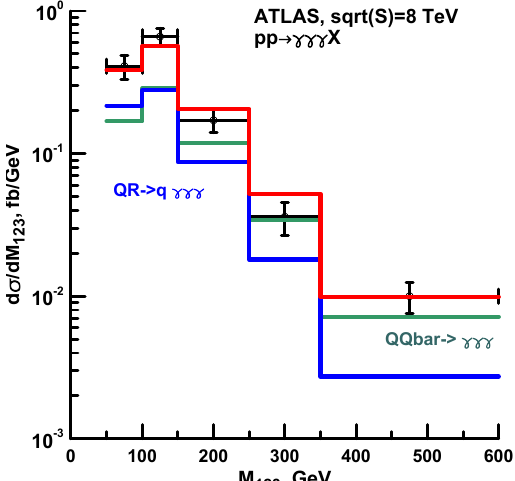
Figure 1: The differential cross sections as function of three-photon invariant mass M . The hard scale in PRA calculation is taken as µ = M 123 corresponds LO contribution (4), the blue histogram corresponds NLO contribution (5) and the red histogram is their